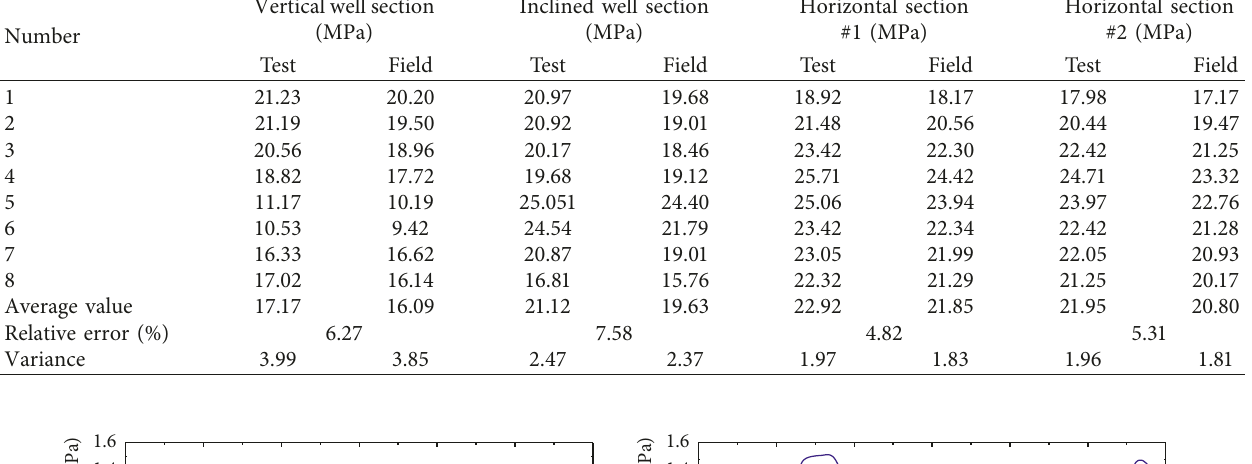
Table 4: Near-wall pressure test results and field